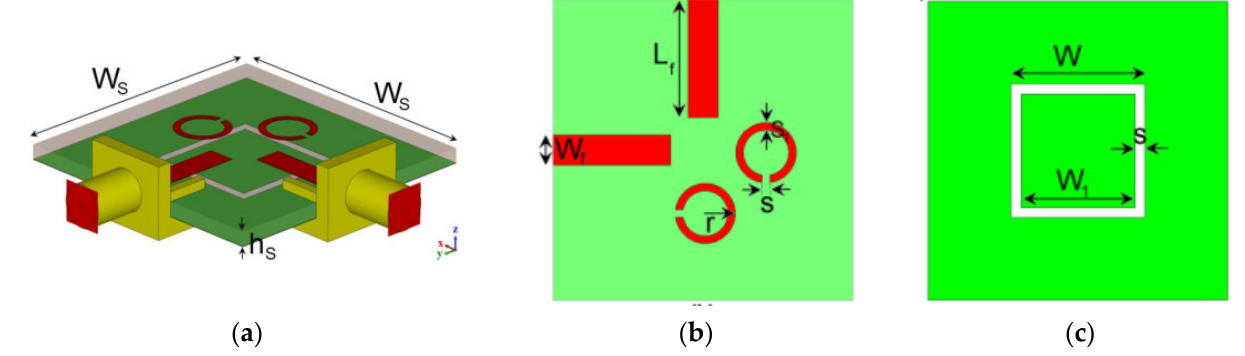
Figure 9. Dual-polarized square ring slot antenna [14]. ( a ) 3-D view, ( b ) Front view, ( c ) Back view.